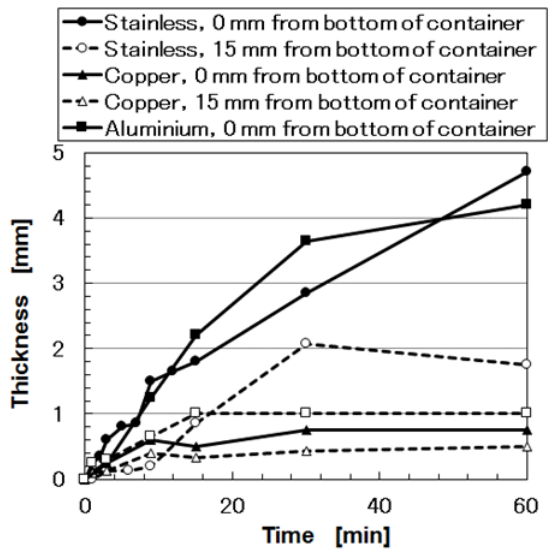
Figure A3. Change of the thickness of vulcanized MCF rubber via electrolytic polymerization with time.